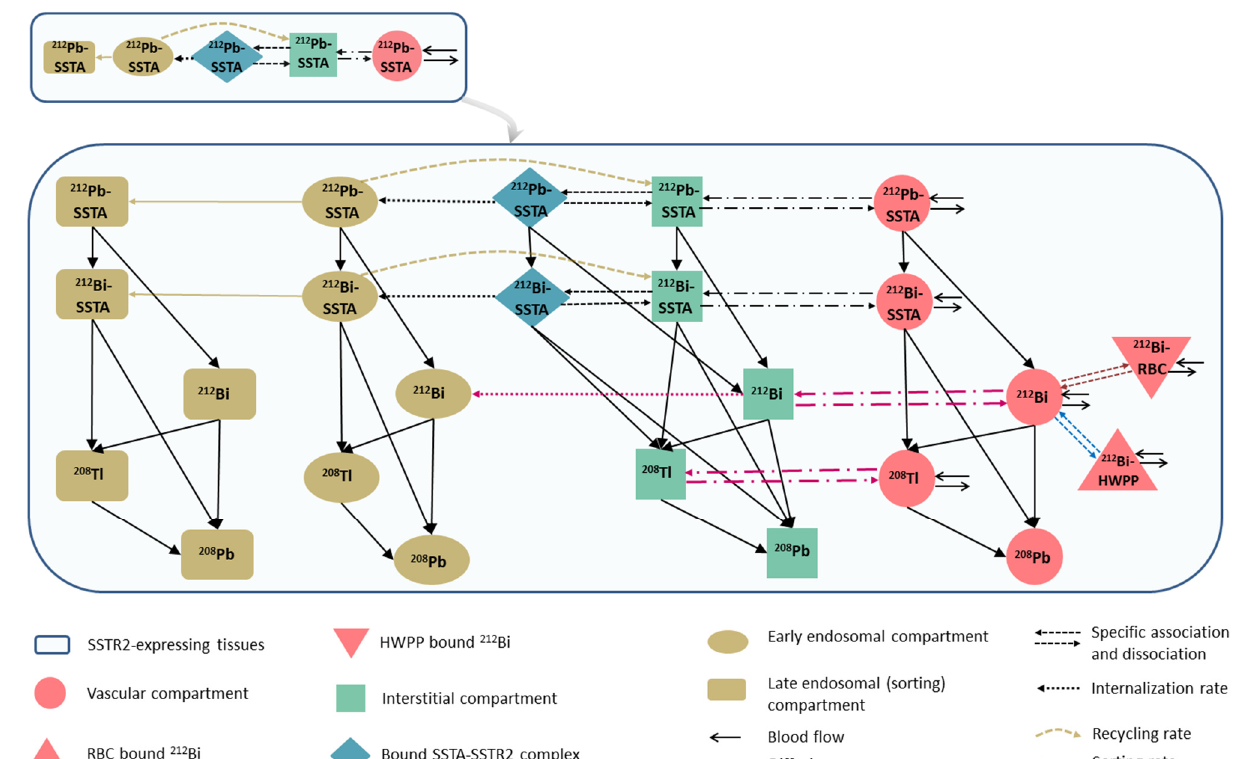
Figure 3. Detailed scheme of the structure of SSTR2-expressing tissue incorporating the in vivo alpha particle generator model and relevant pharmacokinetic parameters of free 212 Bi. [ 212 Pb]Pb-SSTA and [ 212 Bi]Bi-SSTA are assumed to follow the same PK throughout the tissue. Free 212 Bi in the vasculature binds linearly with RBC and HWPP followed by free 212 Bi diffusion and uptake by tissue cells. The free daughter 208 Tl is assumed to have the same permeability surface area product as that for free 212 Bi so that it diffuses between interstitial and vascular compartments and redistributes in the circulation. The alpha-emitting 212 Po decays at the site of its production.